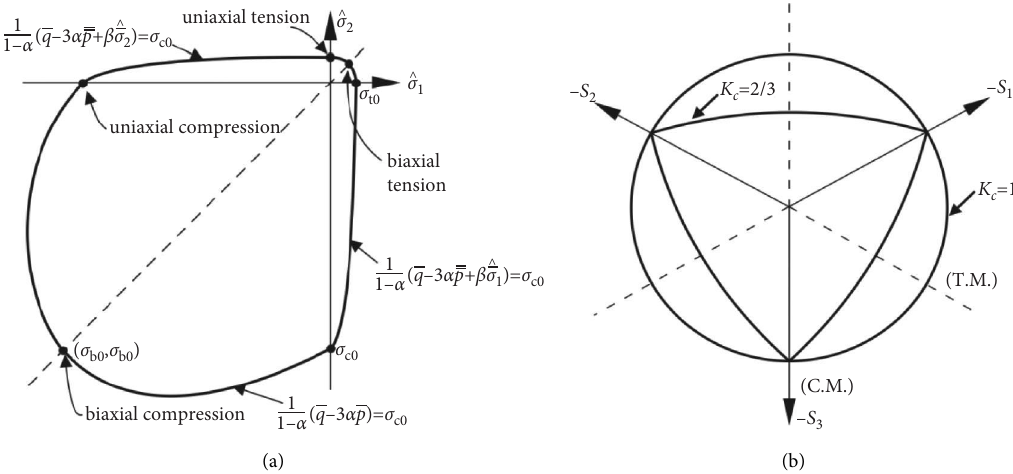
Figure 6: /e yield surfaces and deviatoric plane of the CDP model [33].(a)Yield surfaces. (b) Deviatoric